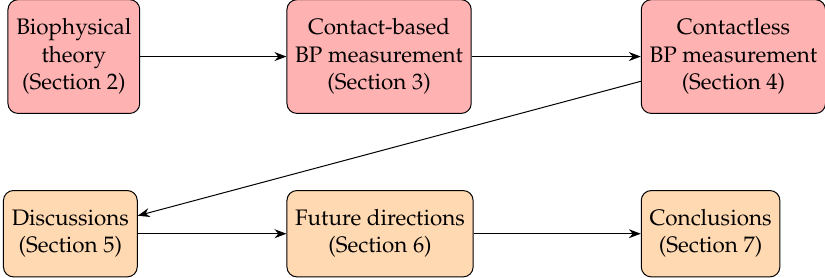
Figure 7. A flowchart showing the organization of this review